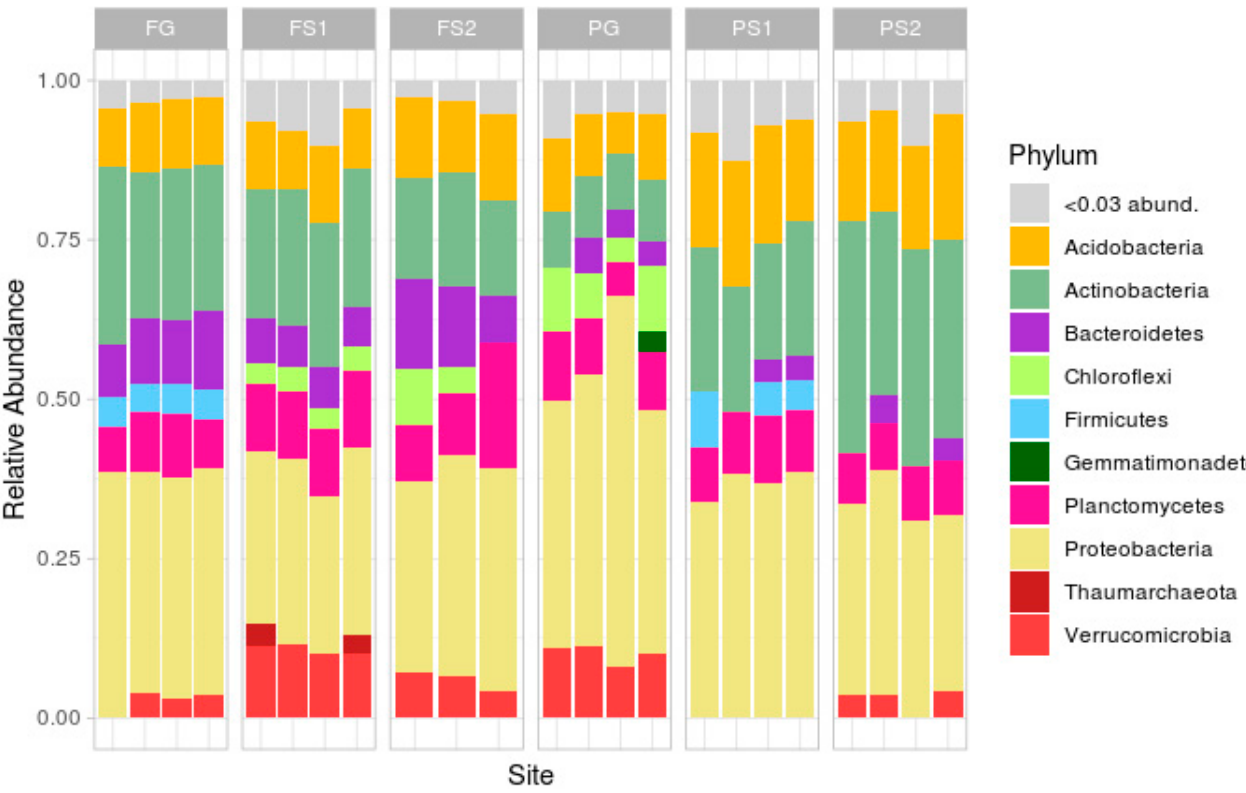
Figure 3. Taxonomic structure of samples at the phylum level.